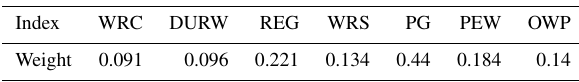
Table 3. The weights of indices by AHP and Entropy